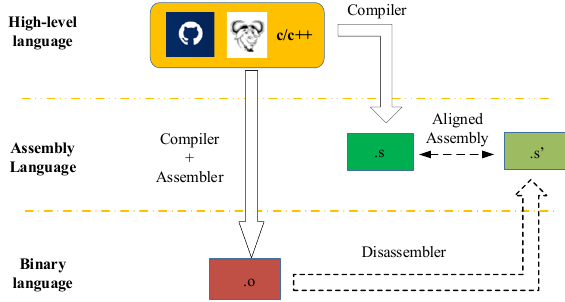
Figure 3. Schematic of aligned assembly generation.